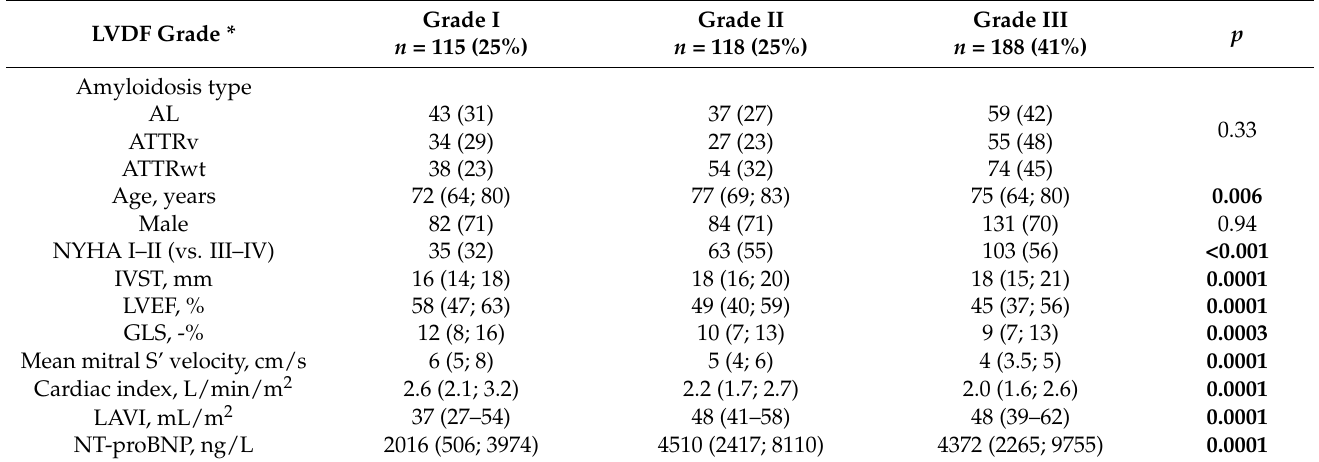
Table 1. Baseline clinical and echocardiographic data according to Left Ventricular Diastolic Function’s grade. LVDF Grade